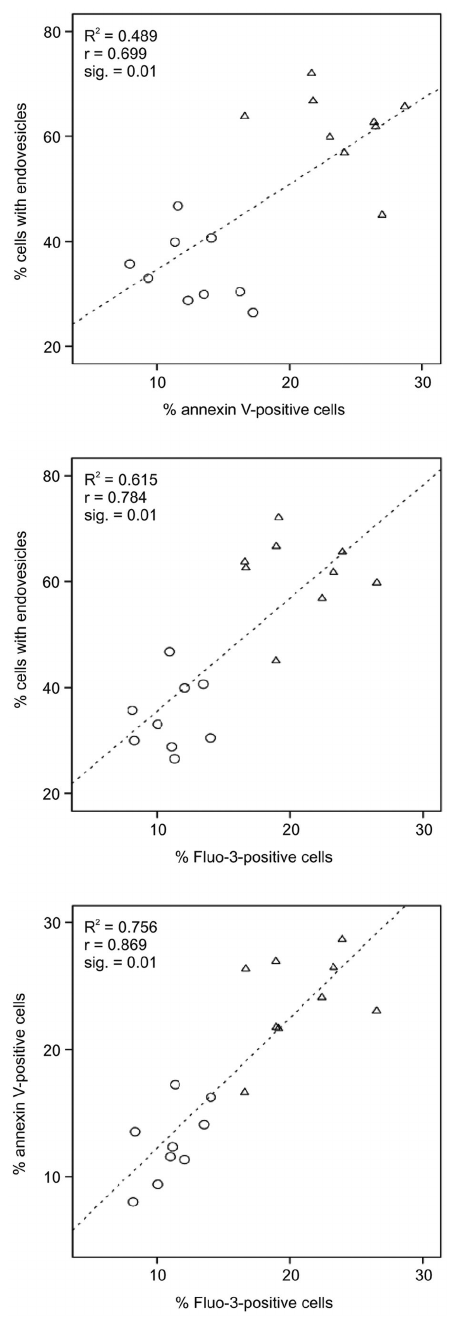
Figure 8. Correlations between drug-induced endovesiculation, LPA-induced PS exposure and calcium uptake. The data of ChAc patients (circles) and respective control samples (triangles) for % of cells with endovesicles upon incubation with primaquine, for % annexin V-positive cells and % Fluo-3-positive cells upon LPA treatment are blotted against each other as indicated (data derived from Figures 4 and 7). Linear regression lines are shown with R2 (shown as inserts). In each combination a positive correlation is observed with Pearson’s r and the 2-tailed significance (given as